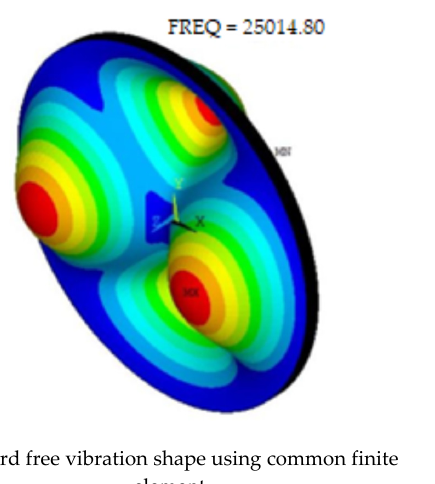
Figure 26. The shape of the third ( a ) frequency ( n = 2; s = 0), Model_I ( a ) and Model_II ( b ). The errors, shown in Table 12, are graphically presented in Figure 27a for the first frequency and in Figure 27b for the second frequency. It can be immediately seen that Model_I lead to results closer to those calculated analytically.